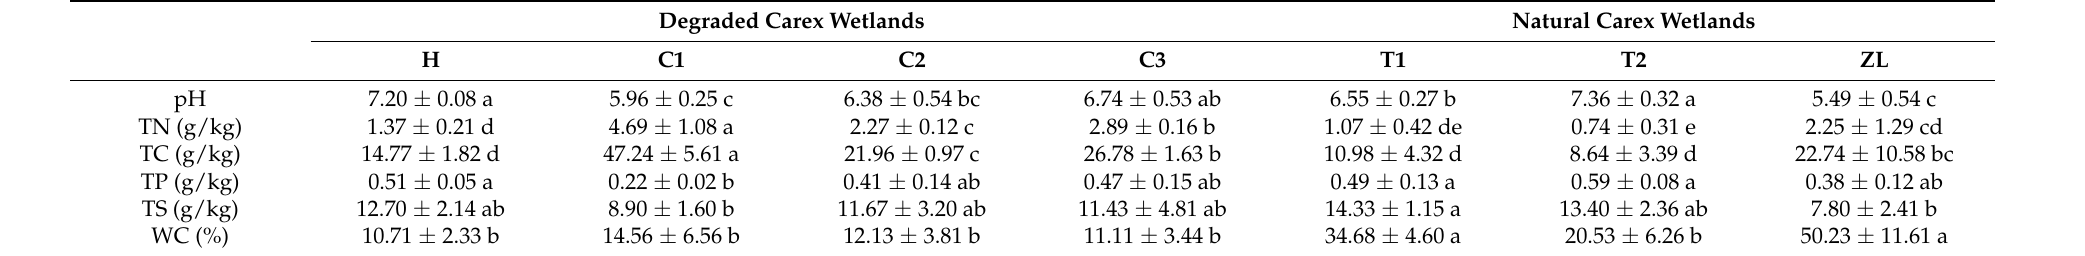
- Different letters in the table indicate statistical differences at p < 0.05, calculated by one-way